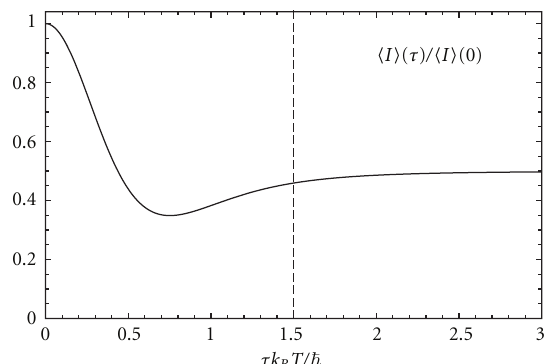
Figure 4: The normalized intensity (cid:4) I (cid:2) ( τ ) / (cid:4) I (cid:2) (0) as a function of T / (cid:2) for the case of thermal light in the signal port and a ≡ τk B 0 vacuum in the LO port and for d = 3. We infer a characteristic thermal coherence time τ c in terms of a (cid:13) 1 . 5 (dashed vertical line), that is, τ c (cid:13) 1 . 5 (cid:2) /k B T